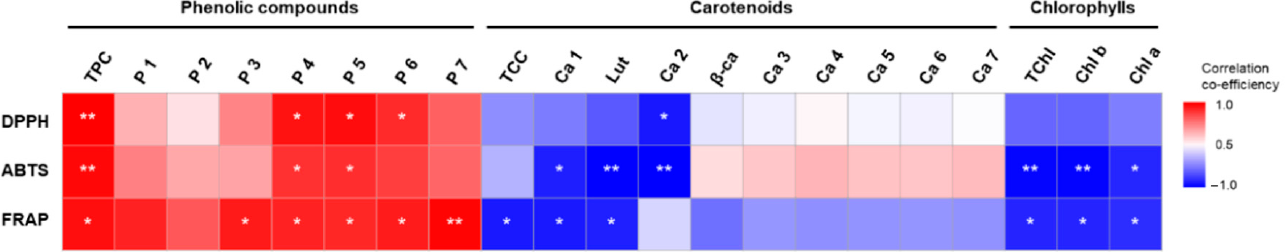
Figure 4. Correlation coefficients between antioxidant activities and phytochemicals in heat- processed M. charantia . TPC: total phenolic content; P1–P7: candidate phenolic compound 1–7;